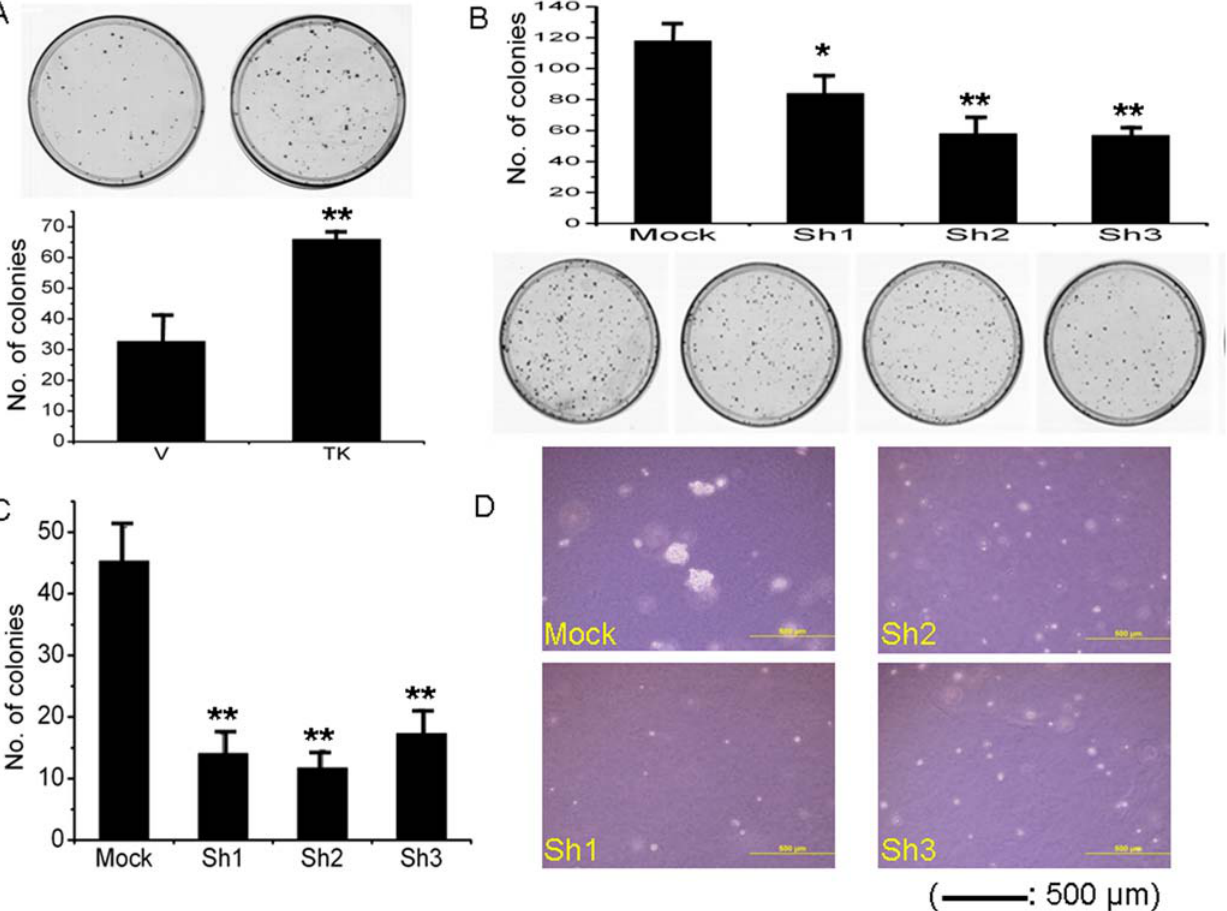
Figure 4. TKTL1 transient transfection and transcriptional repression with shRNA. (a) TKTL1 forced overexpression via transient transfection in background low expressing JHU-011 cells induces increased anchorage dependent colony formation and (b) TKTL1 shRNA in high- expressing FaDu cell line induces growth inhibition. (c) Anchorage independent growth of UM-22B cells is significantly inhibited by TKTL1 shRNA (d), with decrease in colony size. (*=p , 0.01, **=p , 0.001, chi